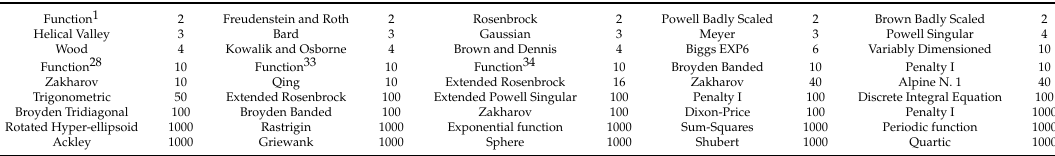
Table 1. Test problems of general objective